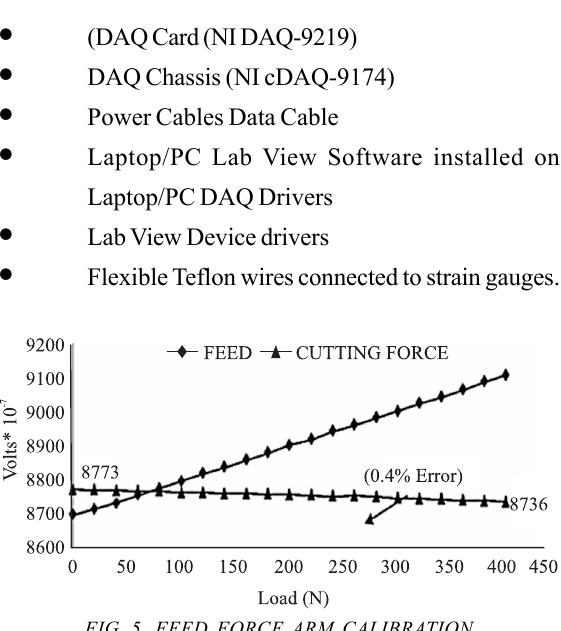
FIG. 5. FEED FORCE ARM CALIBRATION